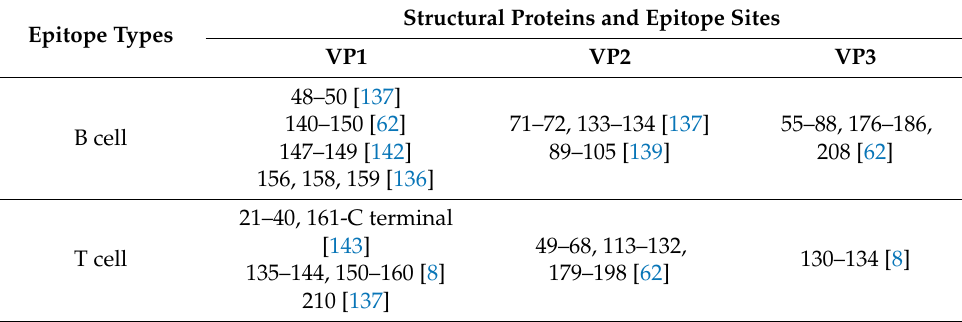
Table 5. Experimentally known epitope regions on FMDV serotype